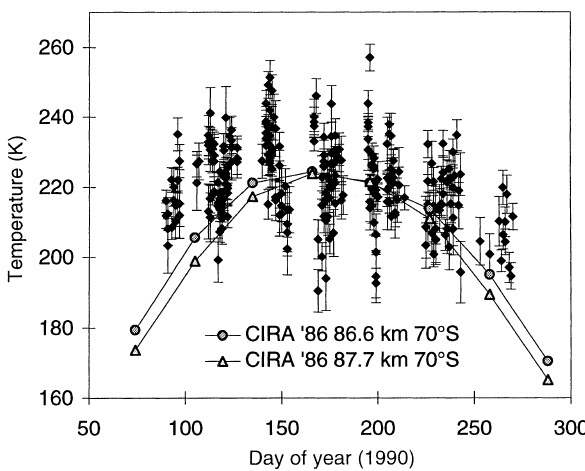
Fig. 4. Seasonal temperature variation for the extended data set (see text) collected during 1990. Temperatures plotted are weighted temperatures for each of the 277 spectra. Error bars indicate the maximum of the weighted standard deviation and the weighted counting error (see text for definitions). CIRA model values are shown for 86.6 and 87.7 km and 70 (cid:14) S.